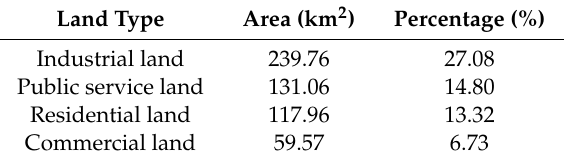
Table 4. Statistics of the newly added construction land in Beijing from 2001 to 2010.